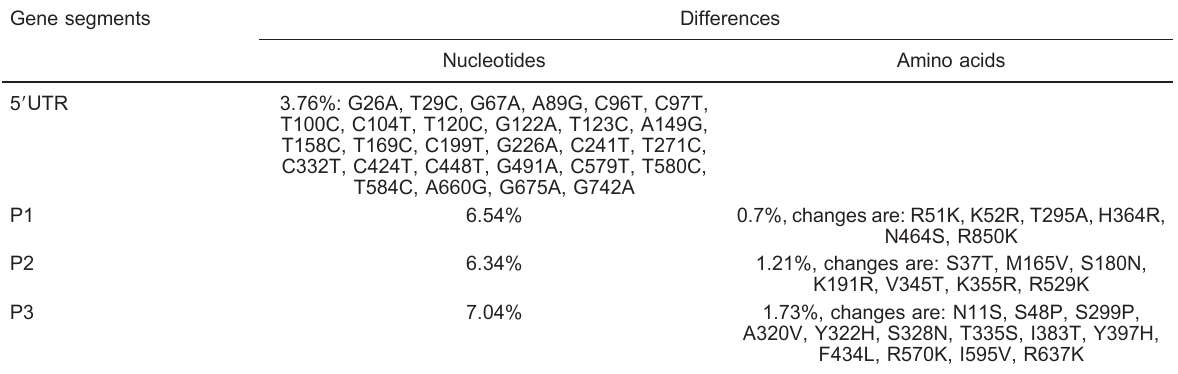
Table 1. Genetic differences between CVA16 CC024 and SHZH05